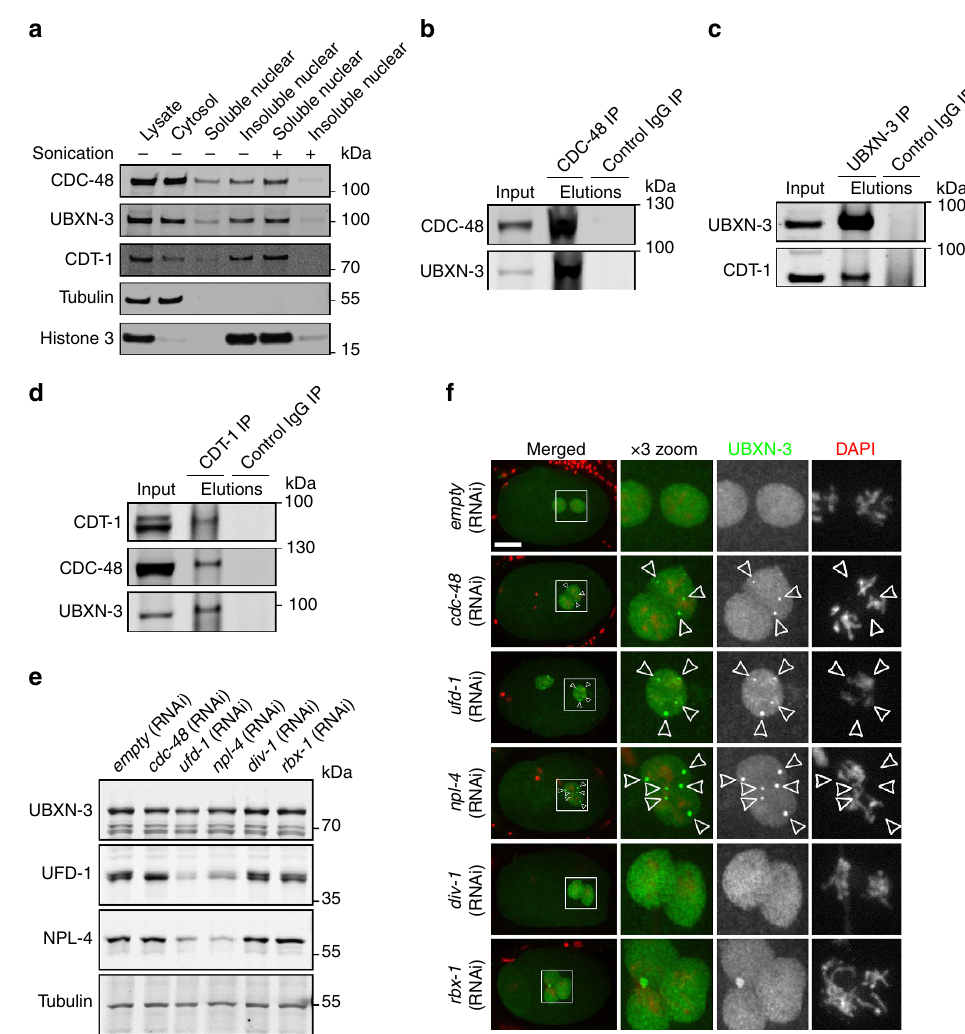
Figure 4 | UBXN-3 interacts with CDC-48 and CDT-1 in vivo . ( a ) Cellular fractionation of C. elegans embryos analysed by western blotting to detect CDC-48, UBXN-3, CDT-1, tubulin and histone 3, respectively. Nuclear fractions were left untreated or sonicated to release associated proteins from the chromatin. ( b – d ) wt worm lysates were incubated with the indicated antibodies coupled to Dynabeads Protein A for immunoprecipitation and subsequently analysed by western blotting for CDC-48, UBXN-3 and CDT-1. ( e ) Western blot analysis of embryonic lysates depleted for indicated genes by RNAi. ( f ) Projections of confocal images of one-cell stage embryos depleted for indicated genes by RNAi. Embryos were immunostained for UBXN-3 (green). DNA was stained with DAPI (red). The boxed area is magnified by three times ( (cid:2) 3 zoom). Arrowheads indicate nuclear punctae of UBXN-3. Scale bar, 10 m